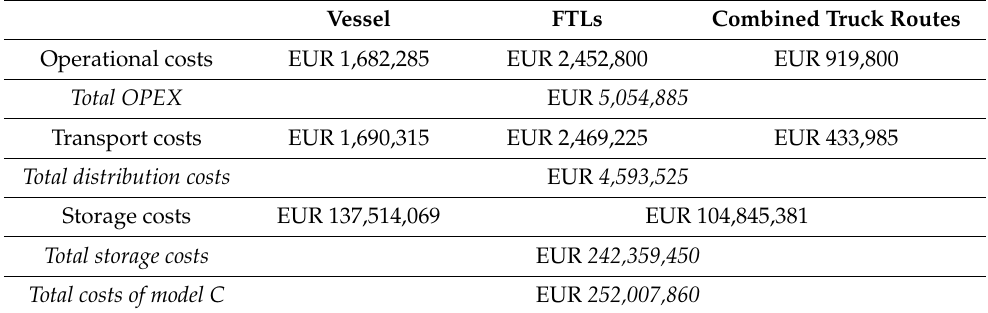
Table 7. Total annual costs of model C. Vessel FTLs Combined Truck